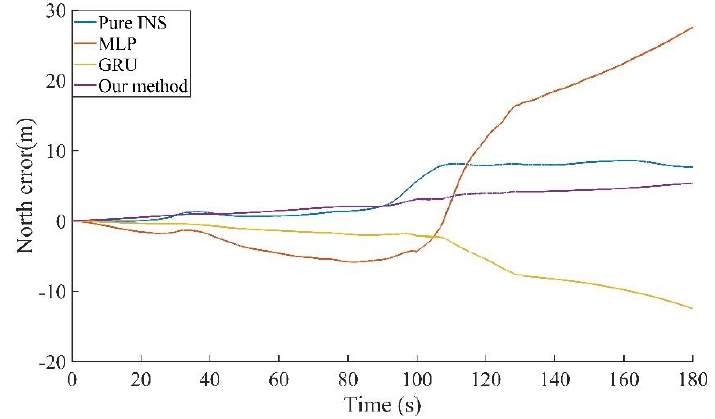
Figure 12. The east position error result of 180 s outage of Experiment 1.